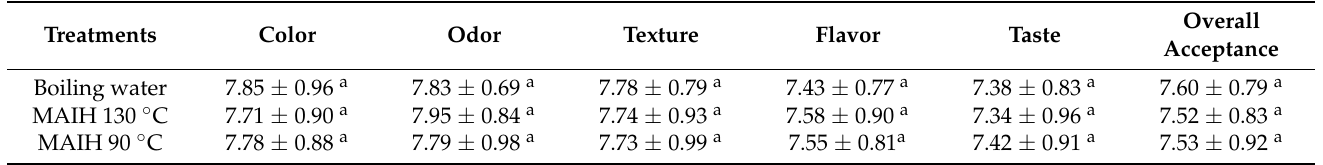
Overall Acceptance